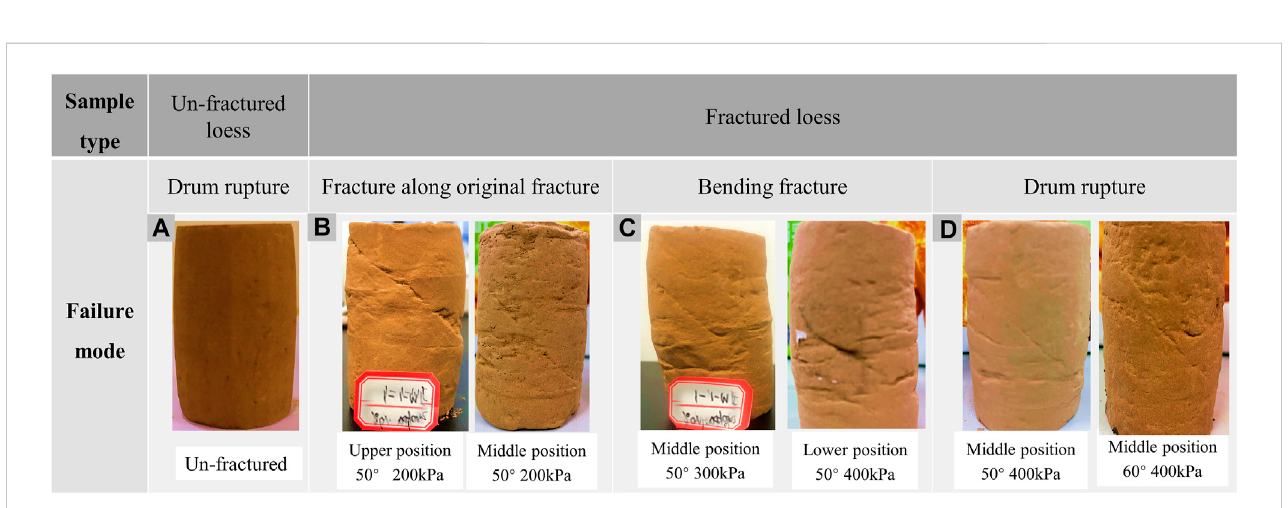
FIGURE 9 Thefailuremodesfortheun-fracturedloessandfractureloess.Un-fractured loess: (A) drumrupture;fracturedloess: (B) fracturealongoriginalfracture; (C) bending fracture; (D) drum